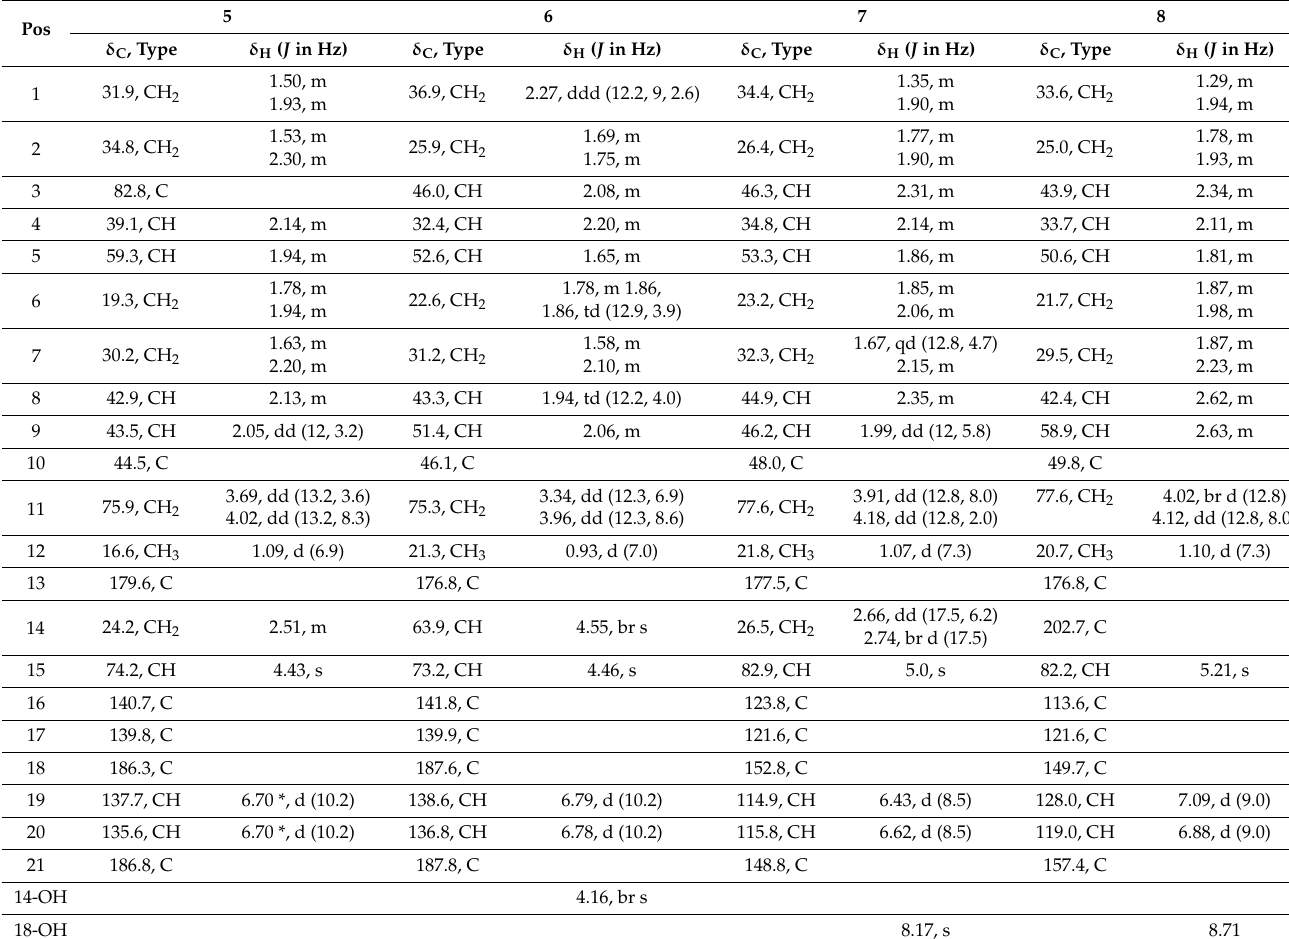
Table 1. 1 H- and 13 C-NMR spectroscopic data ( 1 H 500 MHz, 13 C 125 MHz, CDCl 3 ) for 5 ; ( 1 H 700 MHz, 13 C 176 MHz, CDCl 3 ) for 8 , and ( 1 H 500 MHz, 13 C 125